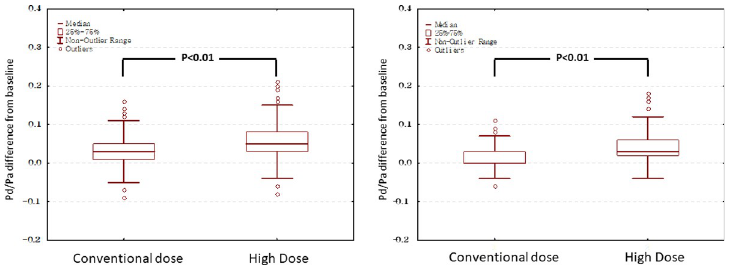
Fig 4. The difference of Pd/Pa from baseline. The difference of Pd/Pa from baseline was increased after high-dose escalation of intracoronary adenosine than that by using the conventional doses of adenosine.